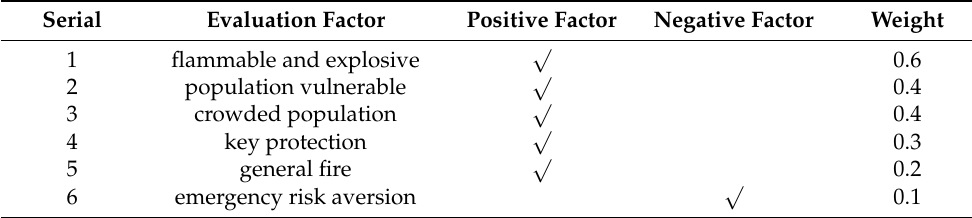
Table 2. Fire risk factors and